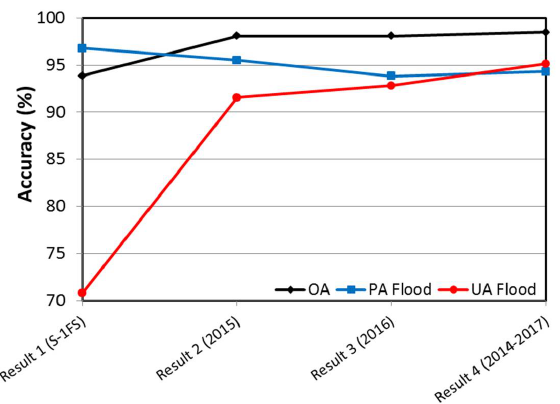
Figure 8. Overall (OA), User’s (UA), and Producer’s Accuracies (PA) of the flood masks produced by the Sentinel-1 Flood Service and of the improvements using SEL 60–100% computed with different time-series lengths.